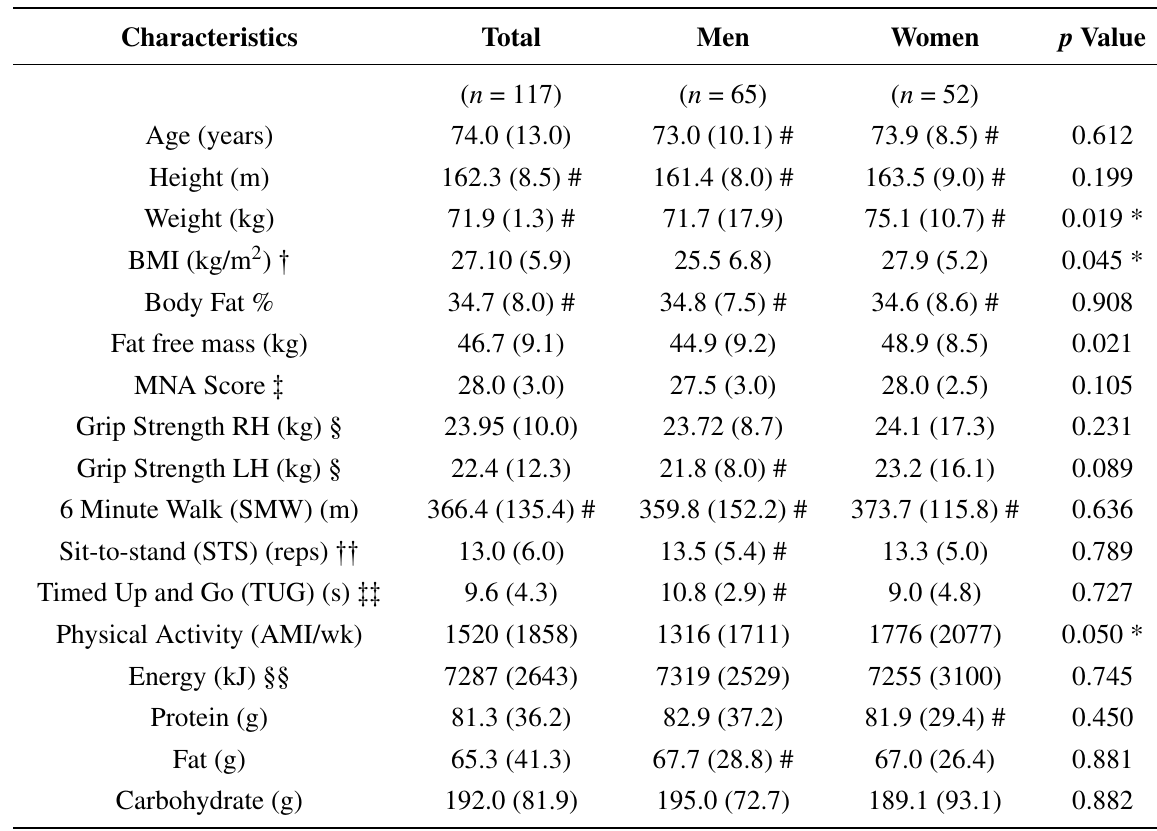
Table 1. Characteristics of study participants: Medians and interquartile range (25th and 75th